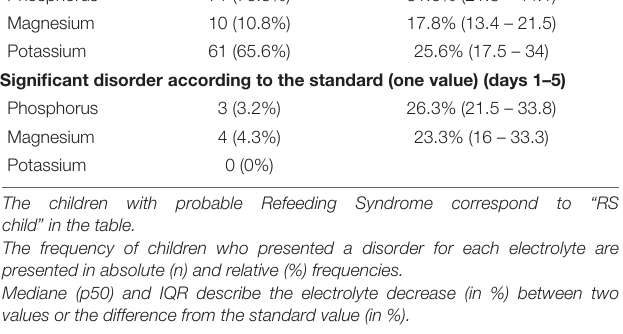
Frontiers in Pediatrics |